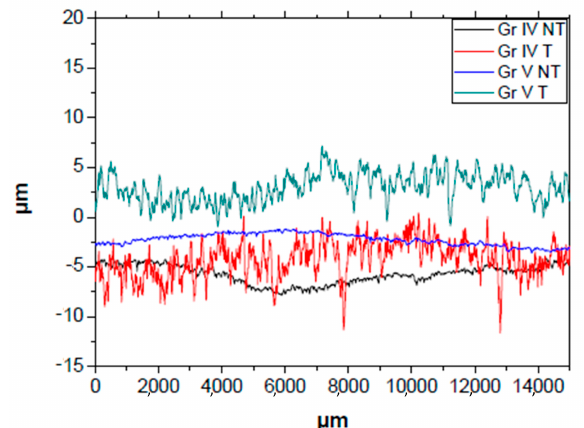
Figure 8. Roughness profile of the untreated with TiO 2 samples. (GR IV: Titanium grade IV; GR V: Titanium grade V; T: SLA Treated; NT: SLA non-treated).